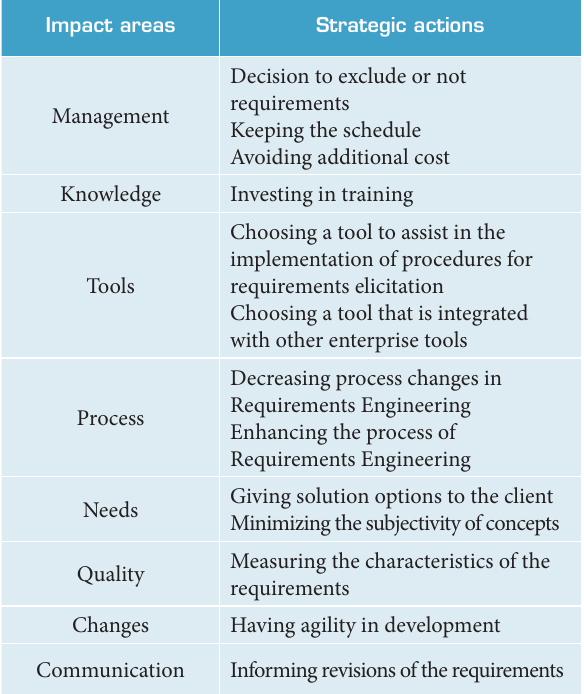
table 6. Impact areas and strategic actions for each